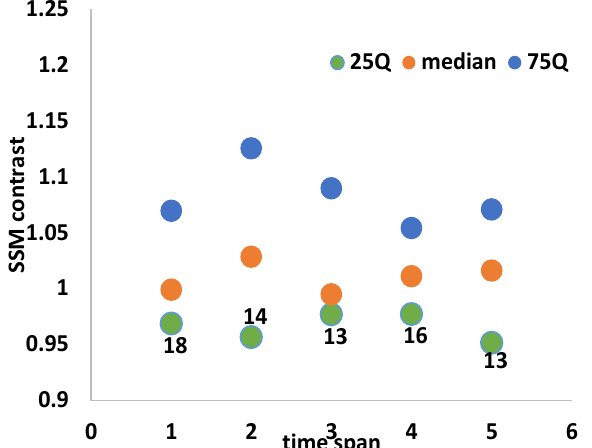
Figure 9. As for Figure 8, but for the S ‐ 1 acquisition dates when precipitation occurred within 24 h.